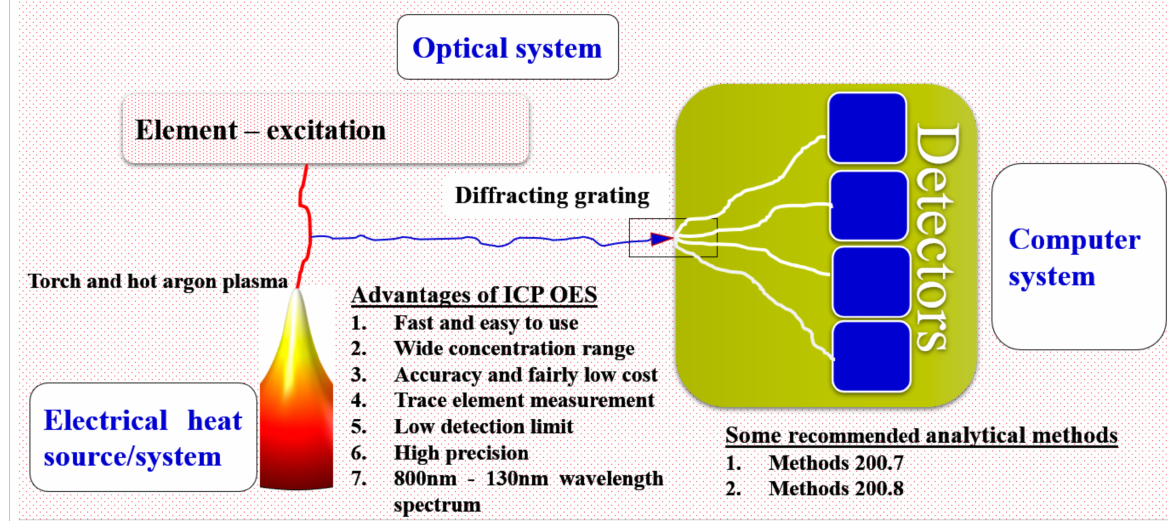
Figure 3. Schematic overview of ICP operation and the advantages for selenium